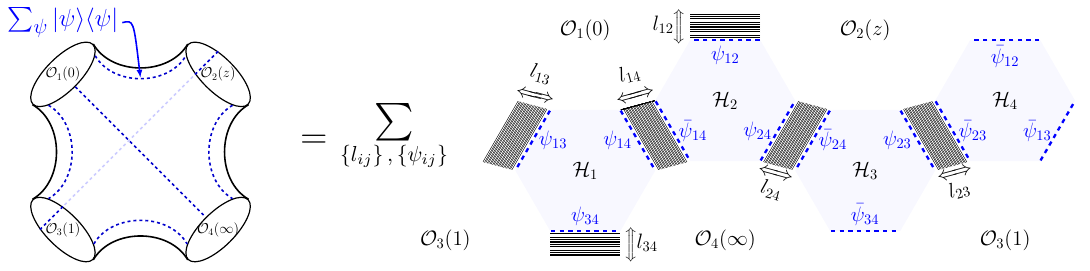
Figure 1 . On the left, the e(cid:11)ective world-sheet that resums all planar Feynman graphs. On the right, hexagonalization: we start with the tree level planar graphs characterized by the Wick contractions or bridge lengths l ij constrained by K 1 = l 12 + l 13 + l 14 (and likewise for the other f g three operators). Each of these graphs is tessellated into four hexagons by inserting a complete basis of 2D intermediate states 1 = on six mirror cuts performed along each bridge l ij j ih j P